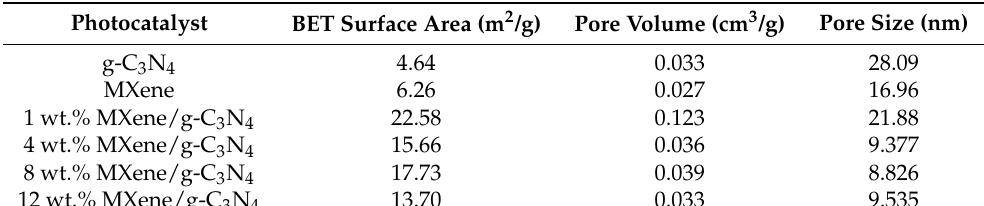
Table 1. BET surface area, pore volume, and pore size of the as-synthesized MXene/g-C 3 N 4 het- erostructure photocatalysts.